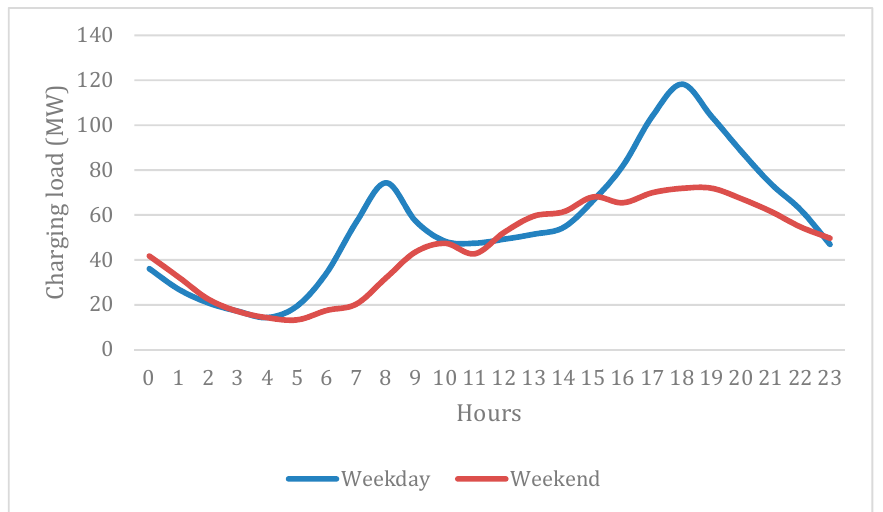
Figure 1. Example plug-in electric vehicle (PEV) Charging Profiles for Weekdays and Weekends.